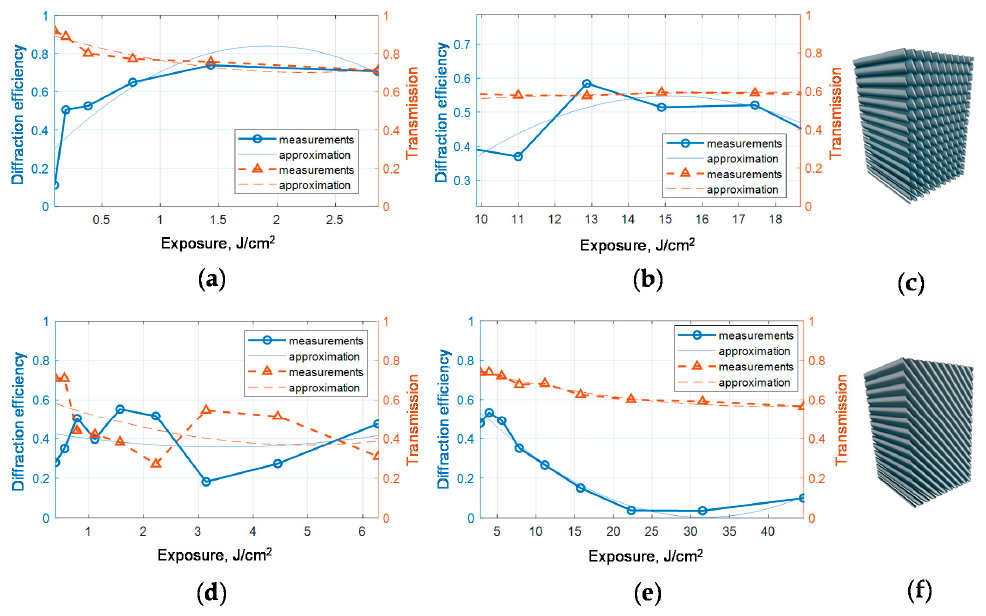
Figure 3. Exposure curves for grating recorded with the surface phase mask for ( a ) small exposures and ( b ) large exposure doses and with Bragg phase mask for ( d ) small exposure doses and ( e ) wide range of exposure doses. 3D-simulation single phase structure in photo-thermo-refractive glass recoded using ( c ) surface phase mask and using ( f ) Bragg phase mask.